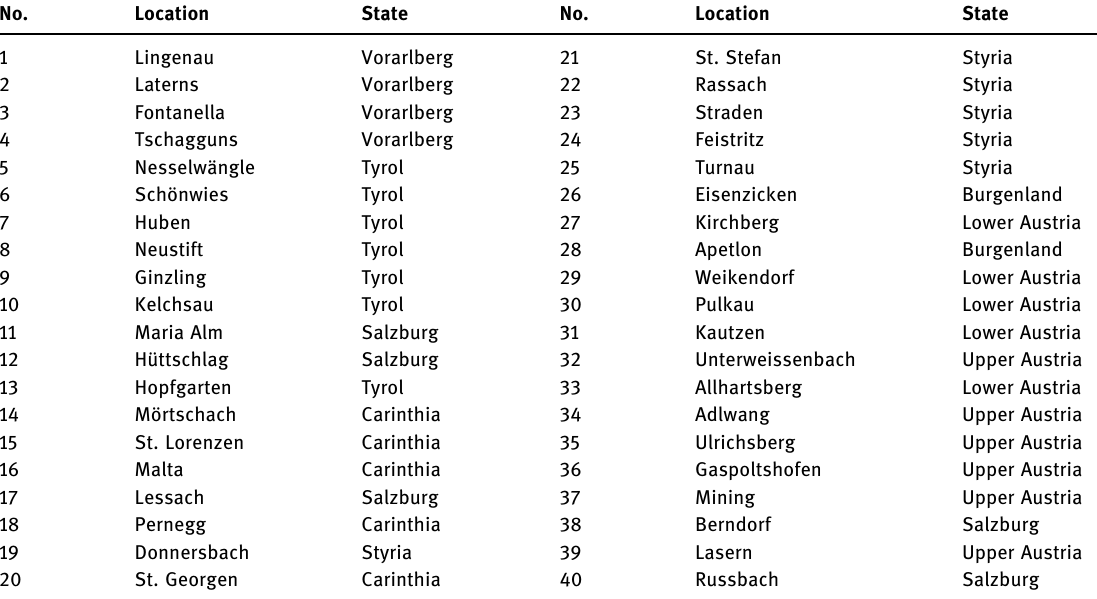
Table A1: Research locations, numbers referring to Figure